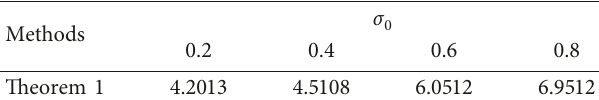
Table 5: The allowable minimum η K K P , and I and different σ 0